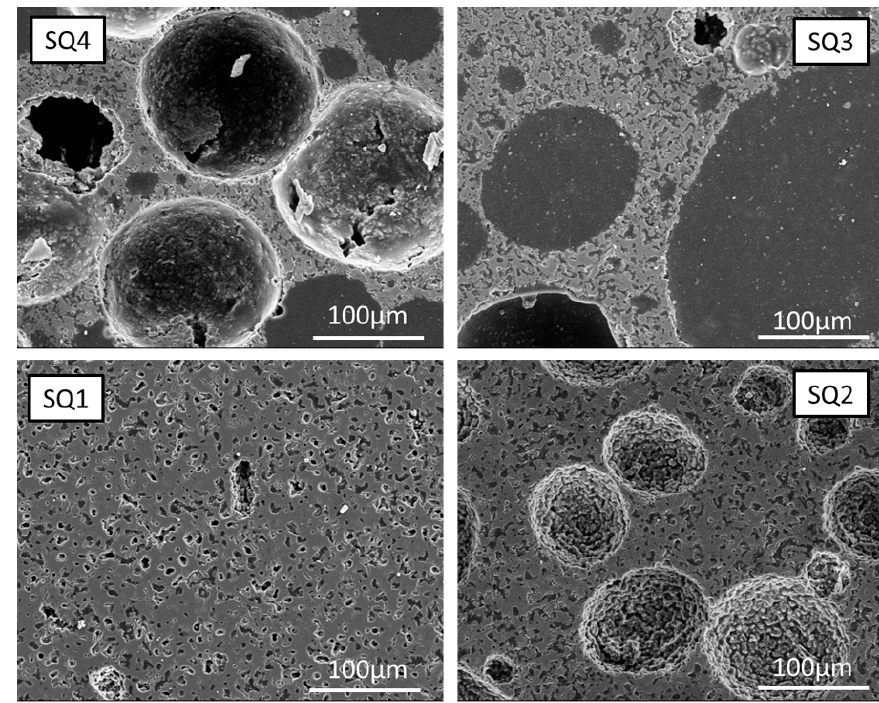
Figure 5. Sintered samples produced with 10–40 wt% PMSQ.